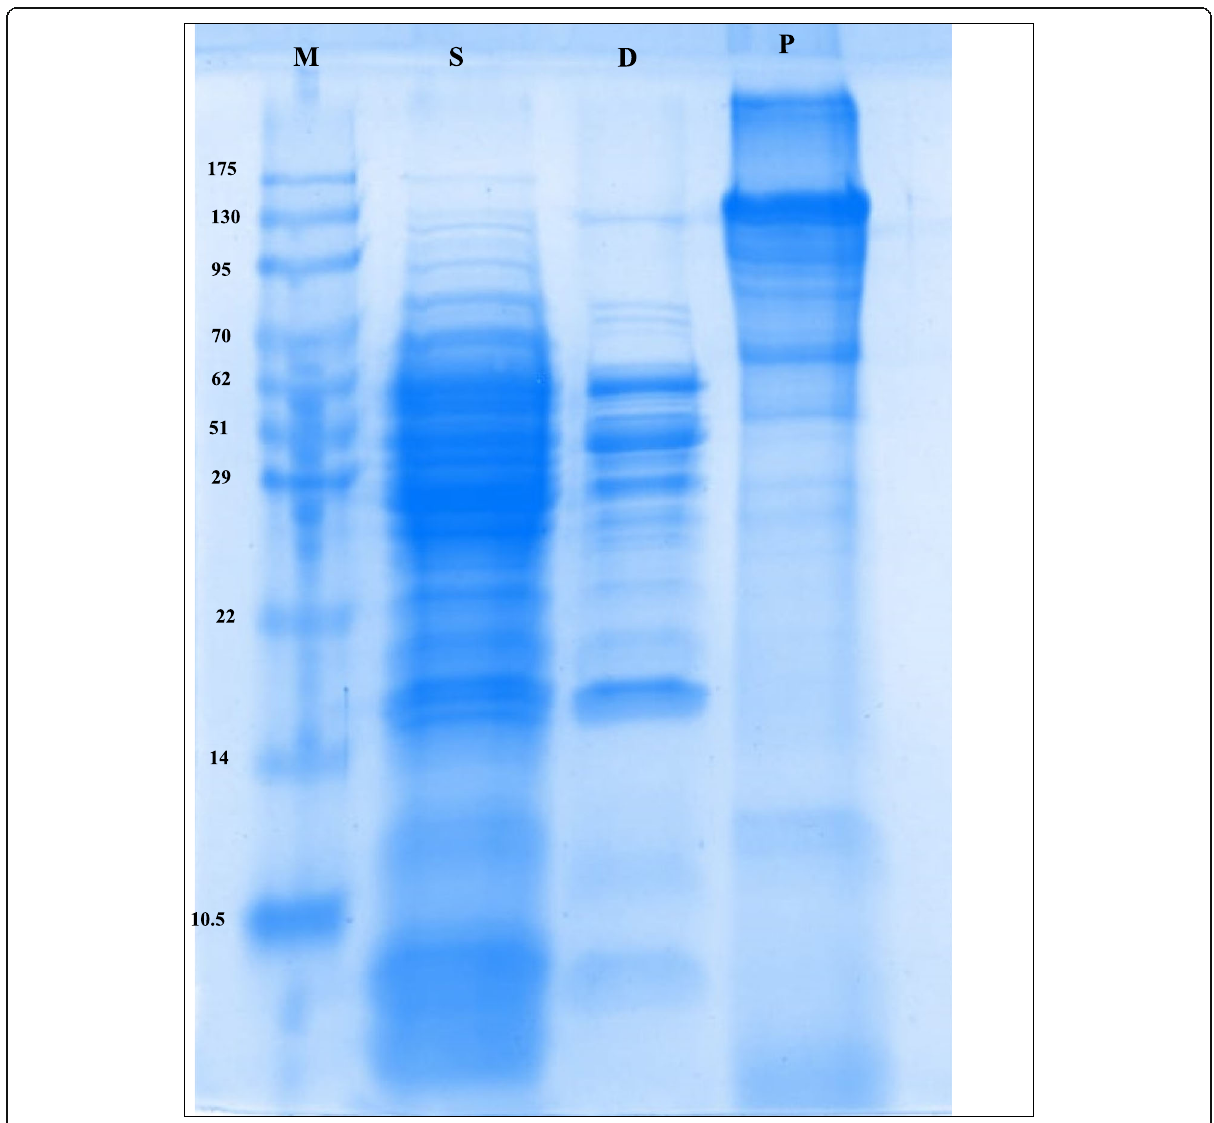
Fig. 3 SDS-PAGE of spore-crystal mixture from Bacillus thuringensis isolates. M, protein marker, S, El-Sharkyia isolate, D, Damietta isolate, and P, positive control from B. thuringiensis